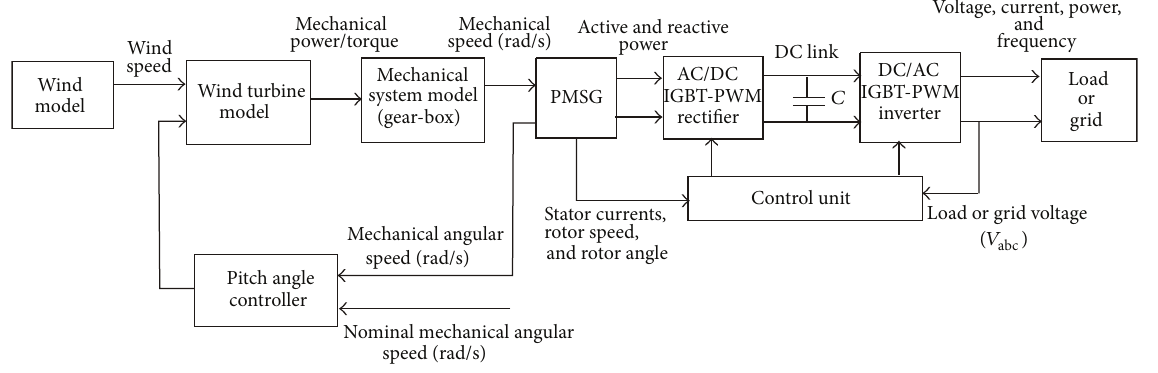
Figure 1: Block diagram of PMSG-based VSWECS with AC/DC/AC IGBT-PWM power